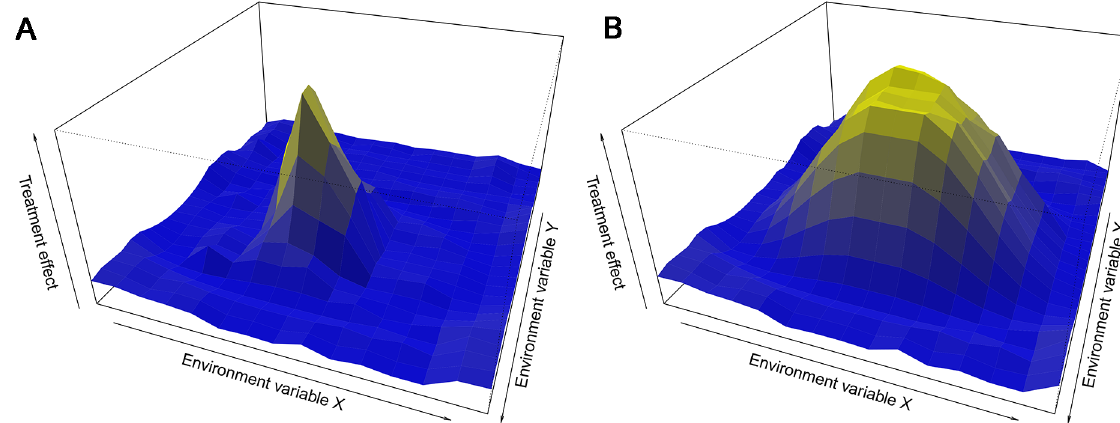
Fig 2. Treatment effect can depend on the environment. The response of an organism to a treatment not only depends on the treatment but also on the state of the organism, which is a function of the current and historic environment. (A) Visualizes a treatment effect that is idiosyncratic to a particular environment. (B) Visualizes a treatment effect that is more generalizable. Whilst idiosyncratic findings are biologically relevant and can give insight to biological function and mechanism, a treatment effect that is more generalizable may be more likely to